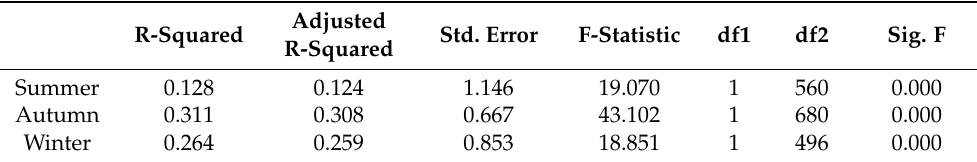
Table 5. The information of the thermal sensation regression models in the summer, autumn,